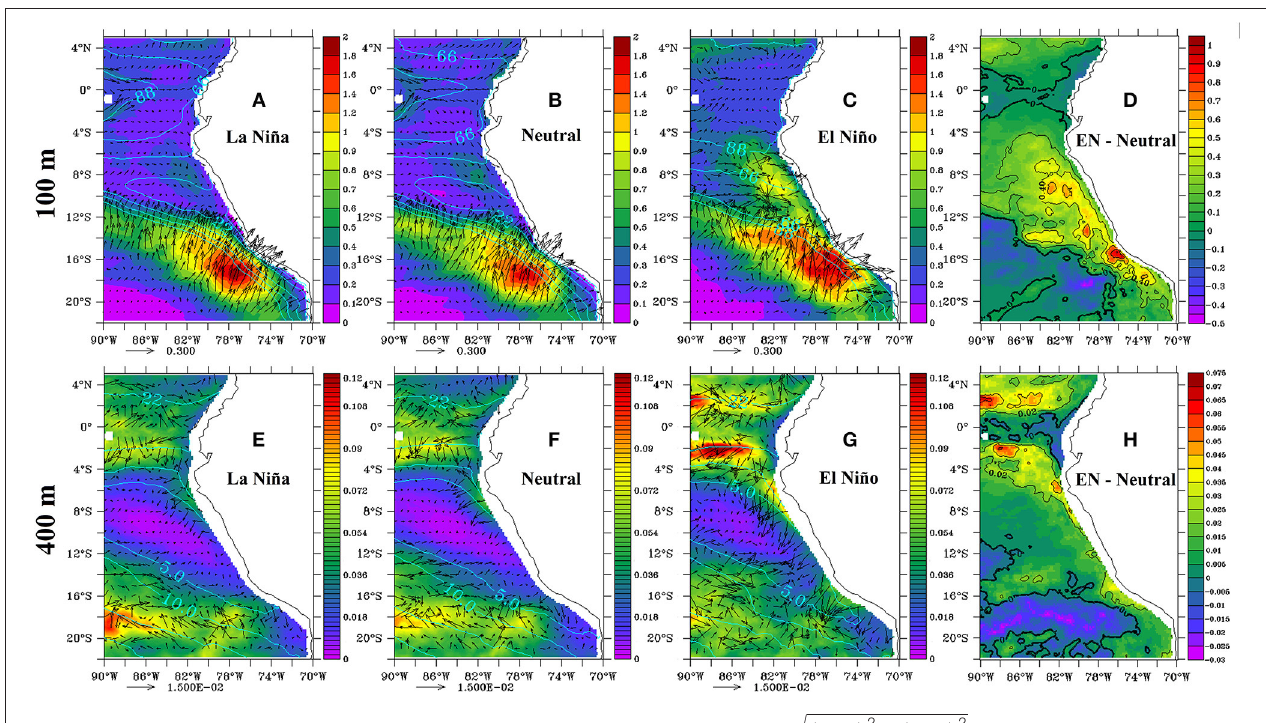
FIGURE 8 | Intensity (colors, in µ mol O 2 m − 2 s − 1 ) and direction (arrows) of the horizontal eddy fluxes ( r averaged during LN (A,E) , Neutral (B,F) , and EN (C,G) events. The differences between EN and neutral period at 100m (D) and 400m (H) are also presented.